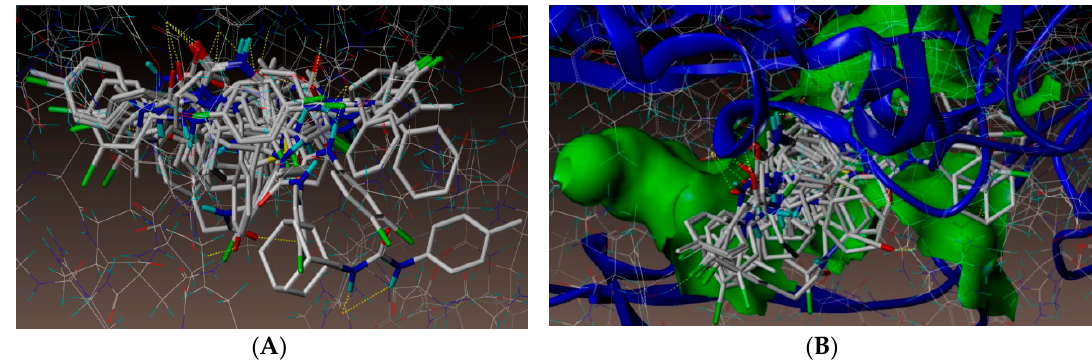
Figure 2. ( A ) All compounds docked into the active site of enoyl-(acyl-carrier-protein) reductase (ENR). ( B ) Docked view of all the compounds at the active site of enzyme PDB ID: 3UDI.